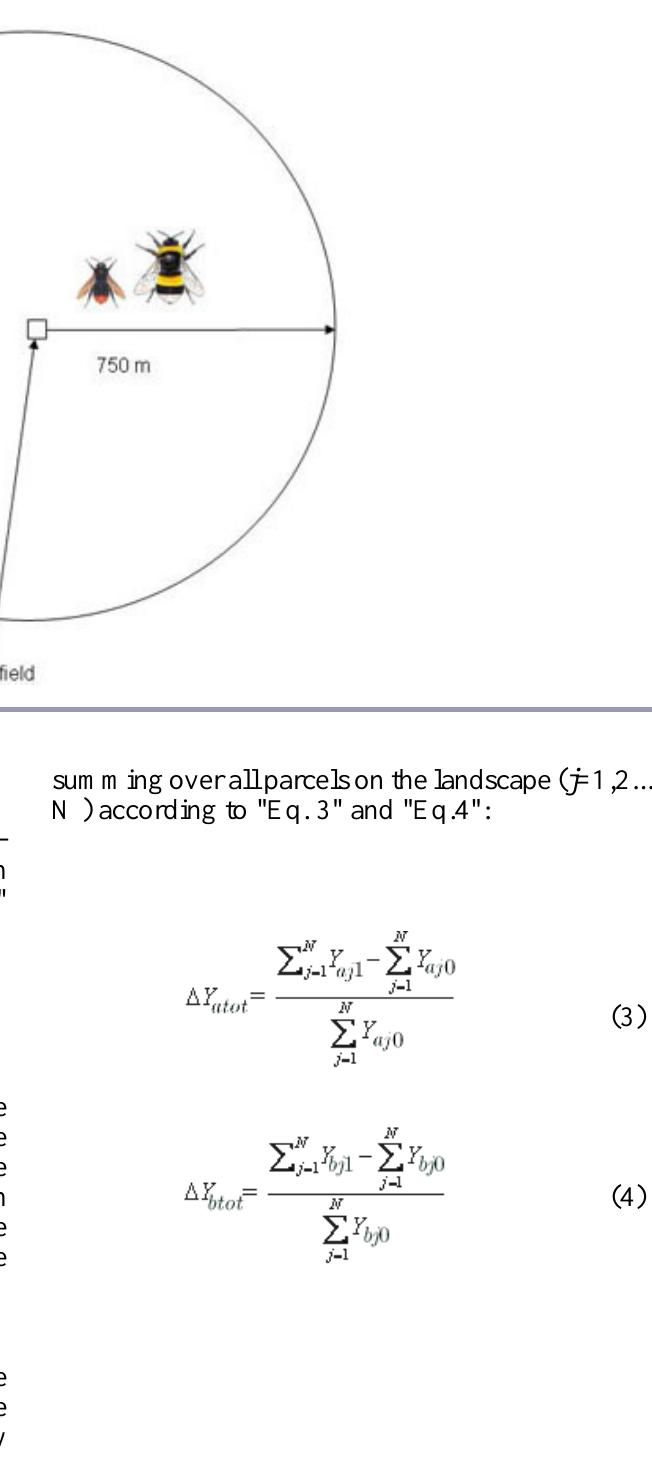
Fig. 2 . Scale of operation of the lumped wild bee pollinator group, i.e. solitary bees and generalists